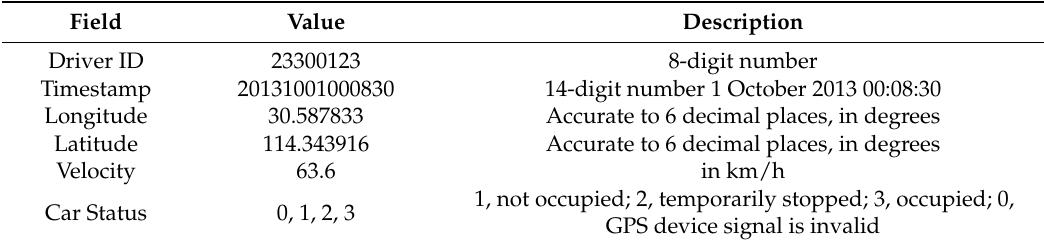
Table 1. Description of the fields of the taxi GPS data.